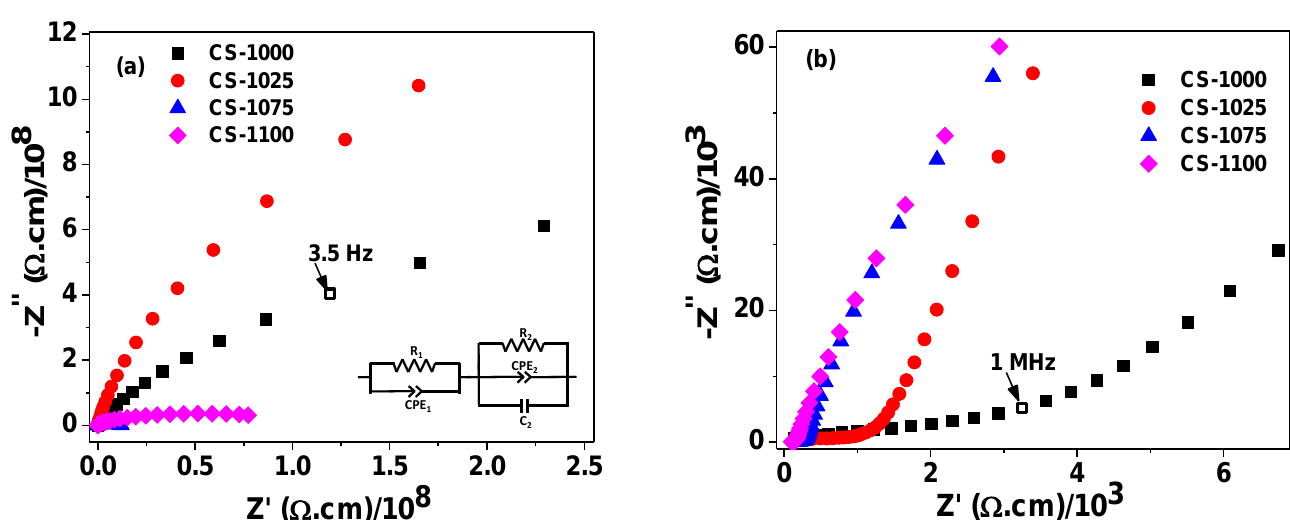
Figure 7. ( a ) Room temperature impedance complex plane plots for the NSCTO and ( b ) zoom-in for the high frequency region.